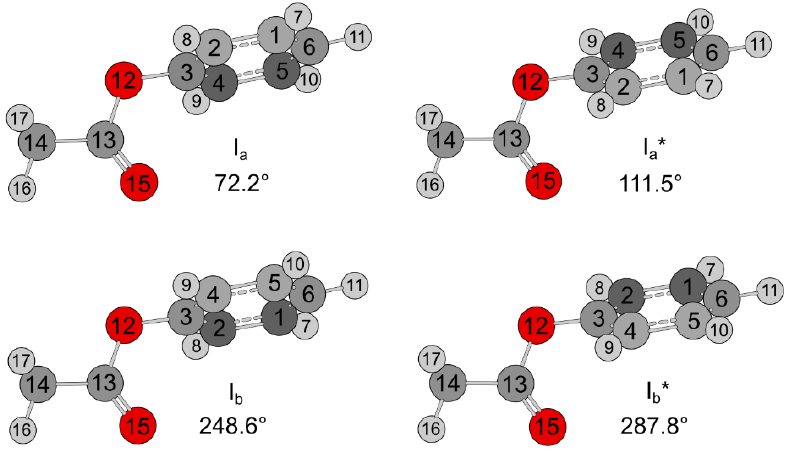
Figure 2. Four minima equivalent in energy at E = − 458.9579885 E h of the most stable conformer I ( entgegen ) of phenyl acetate with C 1 -symmetry. The geometries were fully optimized at the MP2/6- 311++G(d,p) level of theory. The dihedral angle β = ∠ (C 3 -O 12 -C 13 -C 14 ) describes the entgegen orienta- tion of the acetyl group and is 180°, while α = ∠ (C 13 -O 12 -C 3 -C 2 ) corresponds to the orientation of the phenyl ring, which is 72.2° for I a , 111.5° for I a* , 248.6° for I b , and 287.8° for I b* . Note that α ≈ 90° or 270° at the transition states, corresponding to a tunneling angle of about 40° from one minimum to the other.